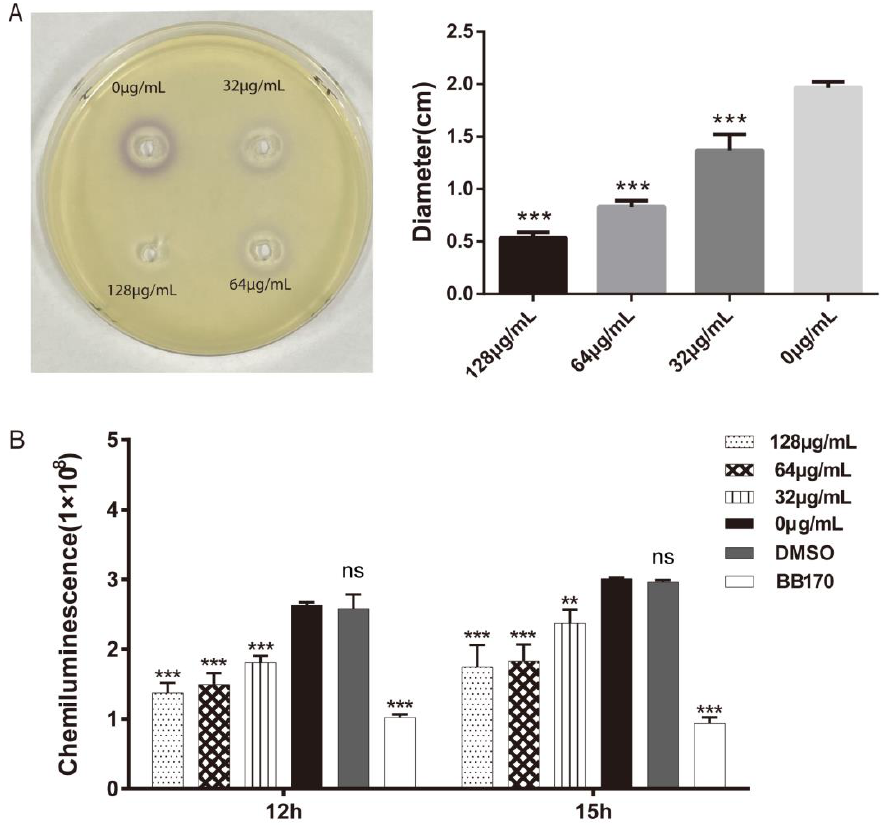
Figure 2. The effect of umbelliferone on the quorum-sensing signals of A. hydrophila . ( A ) Umbelliferone inhibited AHL production in A. hydrophila , which reduced violacein synthesis in C. violaceum CV026. ( B ) Umbelliferone inhibited AI-2 production in A. hydrophila , which reduced bioluminescence intensity in V. harveyi BB170. ***, p < 0.001; **, p < 0.01; ns, not significant, compared with the control (0 μg/mL ).